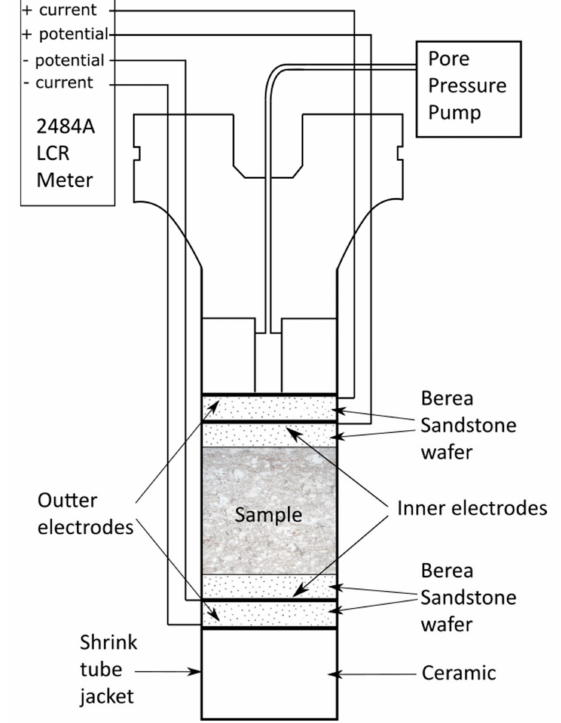
Figure 4. Experimental setup to test electrical resistivity across samples under effective confining pressure [61]. Resistivity was measured with an Agilent 4284A Precision Inductance Capacitance Resistivity LCR meter using a 4-electrode set up, where two outer electrodes drive current and two high impedance inner electrodes measure voltage decrease across the sample. The resulting voltage difference ( ∆ V) was used to calculate resistivity by dividing ∆ V by the length of the sample parallel to current flow. Electrodes were made of platinum mesh coated with platinum black and separated from the sample and each other by wafers of Berea sandstone. The assembled sample column, including the platinum electrode wires, were each jacketed in heat shrink tubing jackets. The sample column was connected to a pore pressure pump for independent pore fluid pressure control and suspended in silicon oil within the confining pressure apparatus to maintain electrical isolation [61].